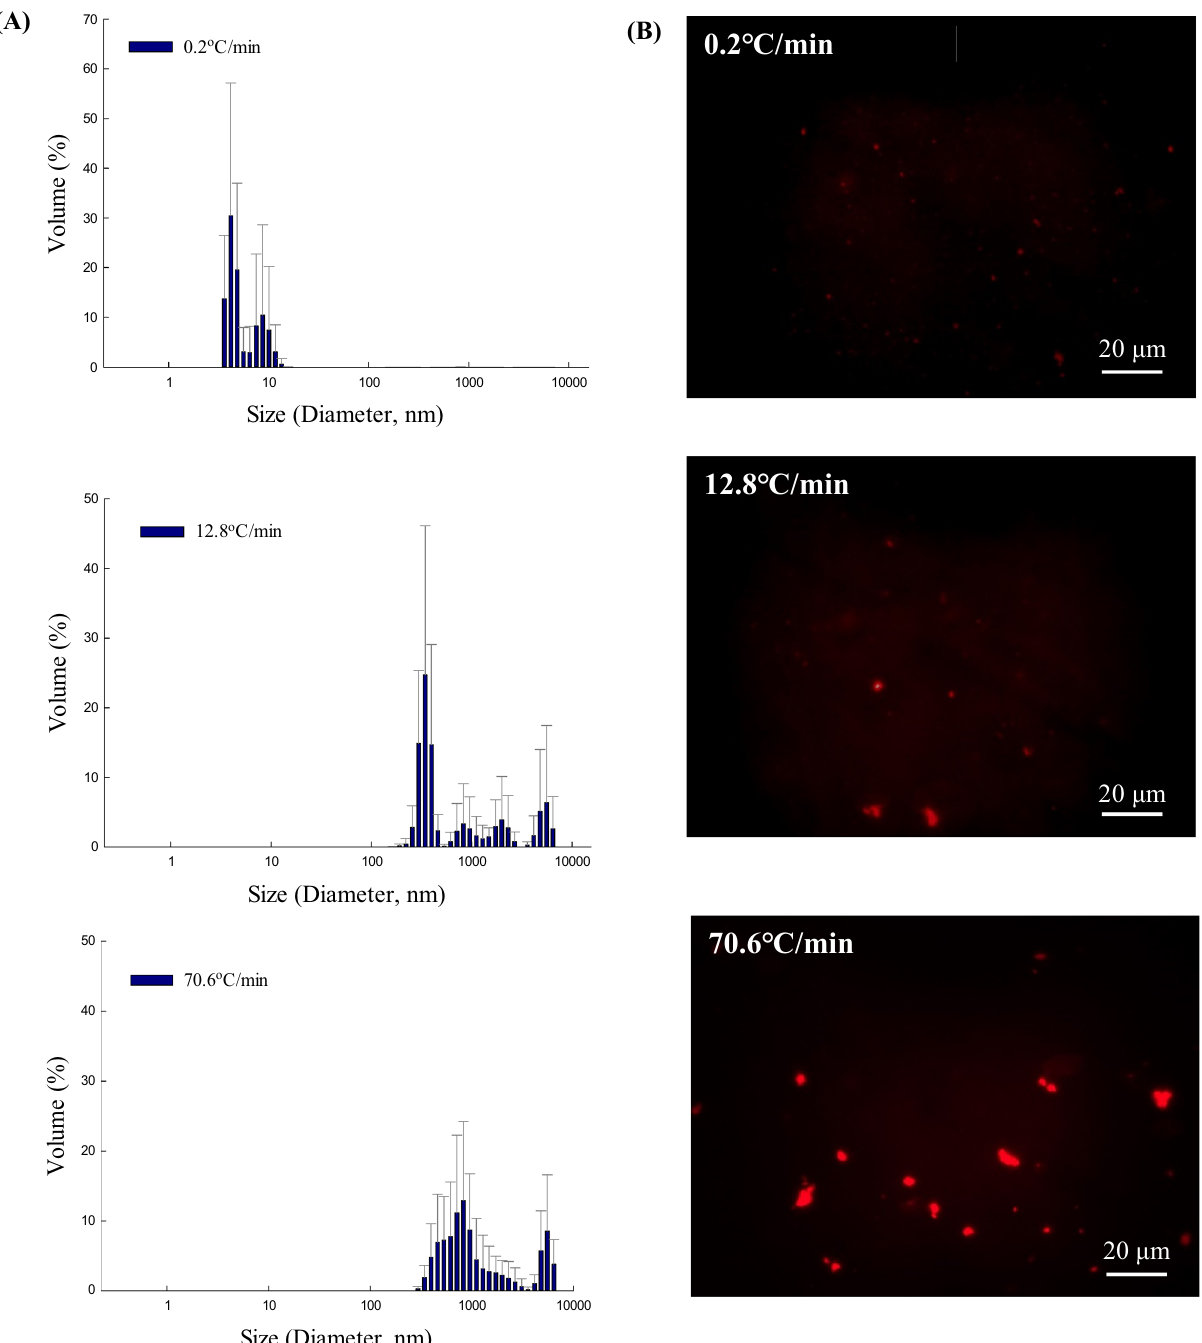
Figure 5. ( A ) Dynamic light scattering analysis of 120 μg/mL LDH in 0.2 M Tris–HCl buffer (pH 7.4) after the freeze–thaw process was repeated five times. The freezing rates were 0.2, 12.8, and 70.6 °C/min. ( B ) Nile Red fluorescence micrographs of 20 μg/mL LDH in 0.2 M Tris–HCl (pH 7.4) after the freeze–thaw process was repeated five times. LDH solution was frozen at a freezing rate of 0.2, 12.8, or 70.6ºC/min. The frozen samples were thawed in a water bath at 25 ºC for 5 min before